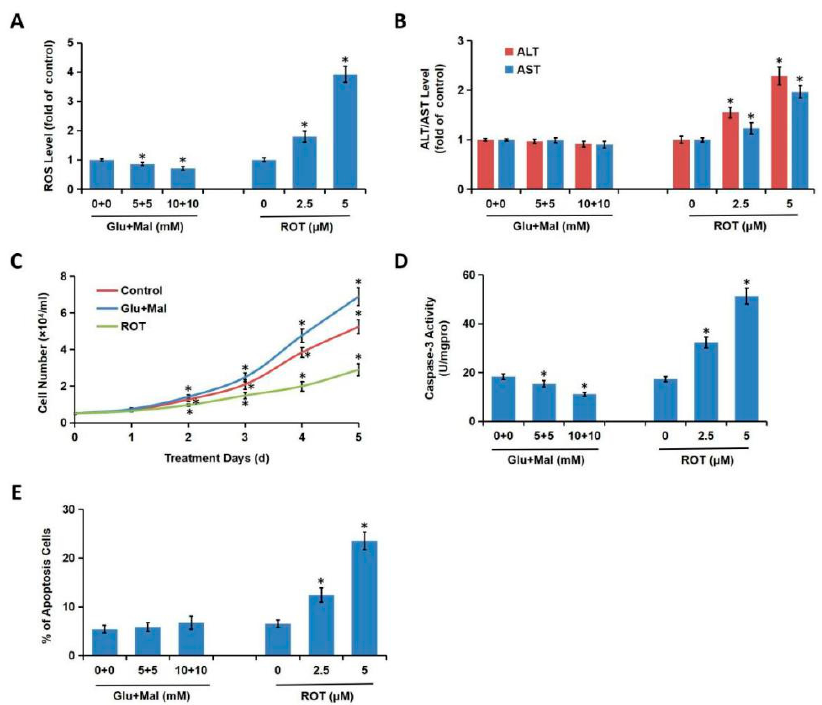
Figure 1. MRCC I inhibition led to cytotoxicity in L02 hepatocytes. ( A ) The L02 hepatocytes were either exposed to different concentrations of MRCC I substrates Glu/Mal (0, 5/5, 10/10 mM) for 1 h and then cultured for 23 h, or exposed to different concentrations of ROT (0, 2.5, 5 µM) for 24 h. ROS level was determined using the fluorescent probe DCFH-DA. ( B ) AST/ALT level was determined using the related kits. ( C ) The L02 hepatocytes were cultured for consecutive 5 days and treated with various concentrations of Glu/Mal (0, 5/5, 10/10 mM; 1 h) and ROT (0, 2.5, 5 µM; 24 h) in day 0 and day 3. The cell number, which indicated growth and proliferation of the hepatocytes, was recorded using a hemocytometer by trypan blue exclusion method. ( D ) Caspase-3 activity was examined using the commercial colorimetric assay kit. ( E ) The cell apoptosis was determined using commercial Annexin V-FITC Apoptosis Detection Kit. * p < 0.05, compared with the control group.